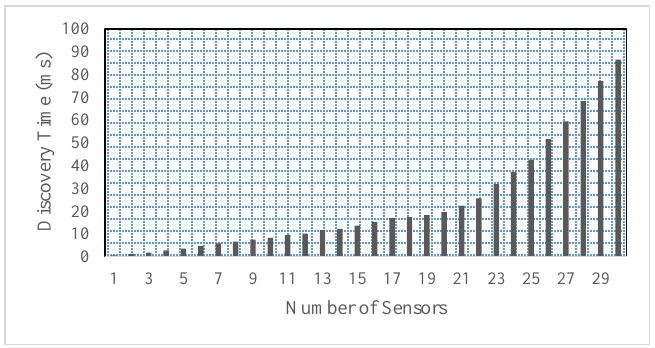
Figure 5. Device discovery analysis.